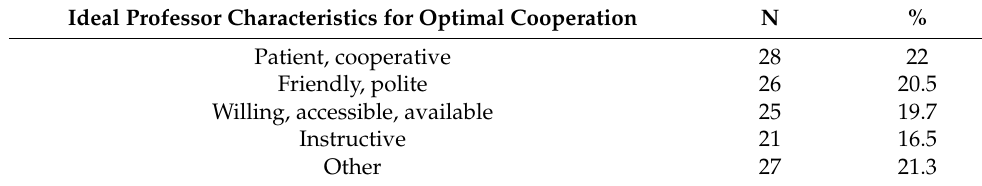
Table 3. Ideal teacher characteristics for optimal